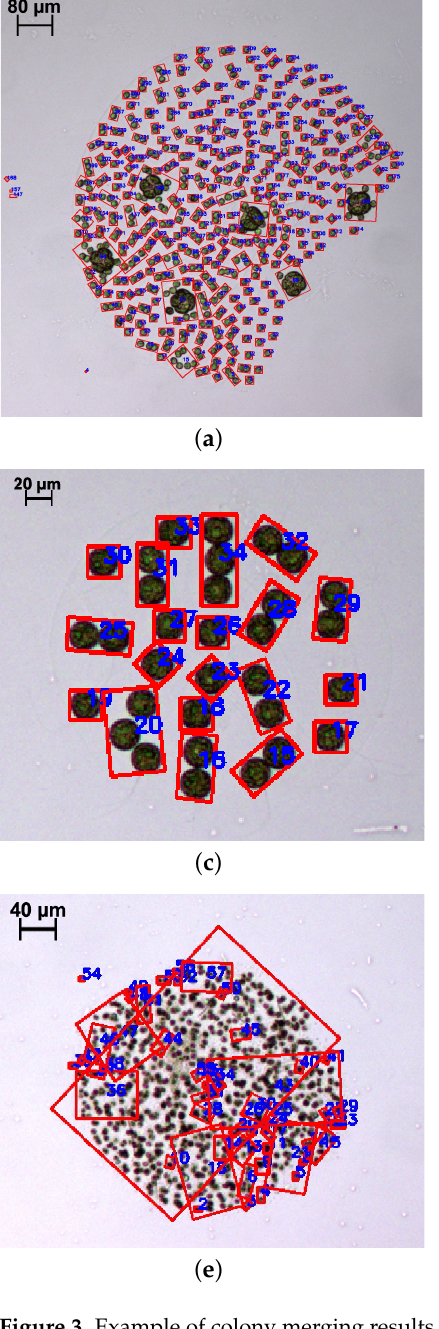
Figure 3. Example of colony merging results over particular specimens (not to scale) . ( a ) Volvox aureus detected in separated parts. ( b ) Same Volvox aureus after the merging algorithm. ( c ) Eudorina elegans detected in separated parts. ( d ) Same Eudorina elegans after the merging algorithm. ( e ) Microcystis flos-aquae detected in separated parts. ( f ) Same Microcystis flos-aquae after the merging